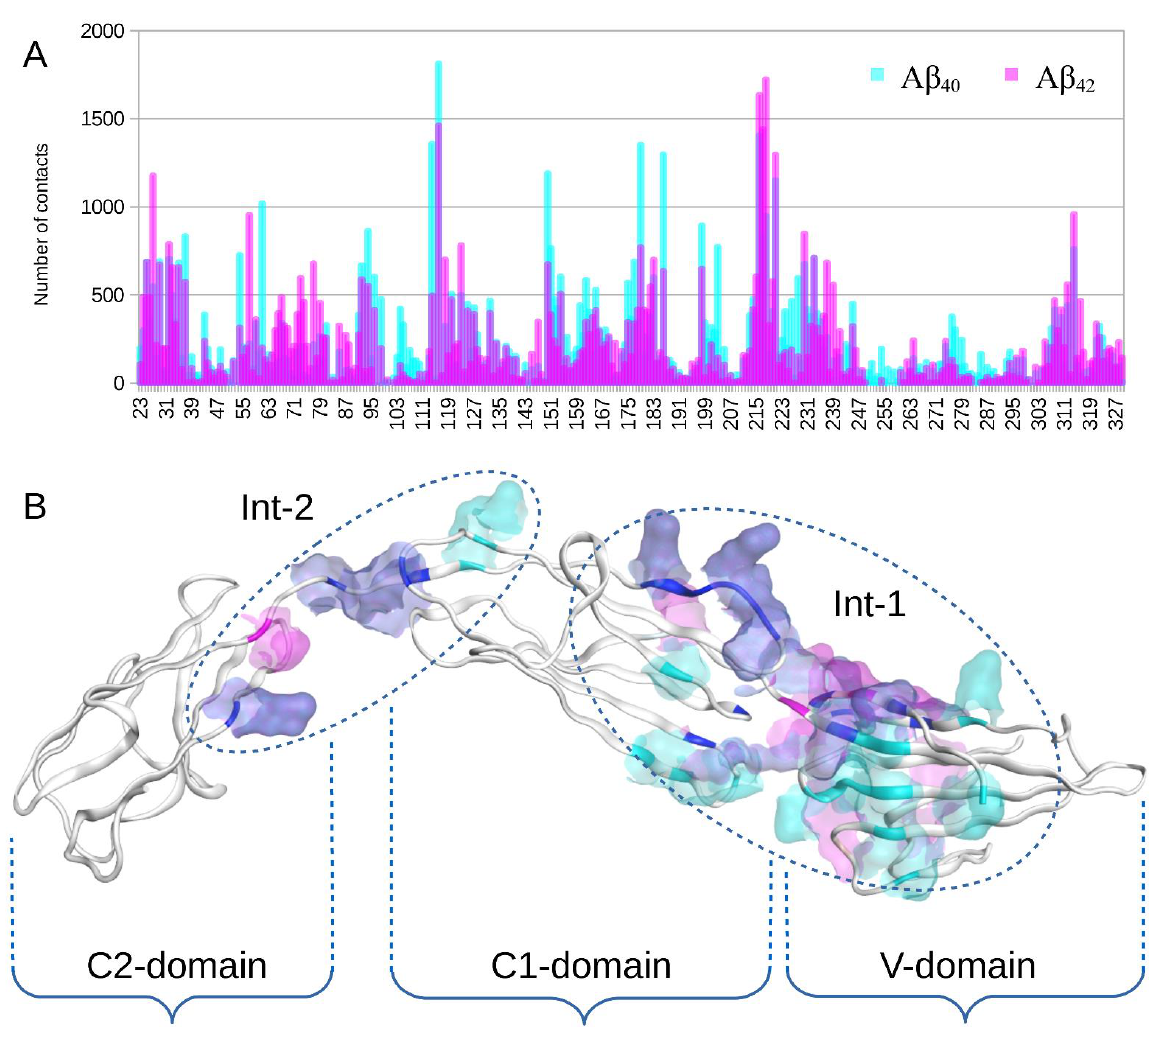
Figure 1. Global dockin g results of Aβ 42 and Aβ 40 peptides to RAGE protein performed with servers LzerD, ATTRACT, PatchDock, ClusPro, Hdock and Zdock and analyzed with QASDOM server. The 30 best complexes from each server have been used for analysis, and 10 complexes from Zdock. ( A ) Superposition of the docking contact frequency histogram for RAGE residues over all 160 com- plexes with Aβ 42 (cyan) and Aβ 40 (magenta). ( B ) Interacting residues highlighted in the RAGE struc- ture according to the global docking results. Residues interacting only with Aβ 42 are highlighted with magenta. Residues interacting only with Aβ 40 are highlighted with cyan. Residues interacting with both isoforms are highlighted with blue. RAGE domains are indicated with curly braces. In ( B ), two independent extended interaction regions localized far from each other can be distin- guished. They are marked with dotted ovals and represent Interface 1 (Int-1) and Interface 2 (Int-2). Figure 2 shows that the interaction interfaces for the three Aβ 42 isoforms are almost identical. Only the sizes of the peaks differ. The total number of contacts in the graph areas was about 15,000 for each isoform (15,666 for Aβ 42 , 15,217 for pS8- Aβ 42 and 14,766 for isoD7- Aβ 42 ). The relative peak maxima changed significantly for different isoforms with an almost equal number of contacts.